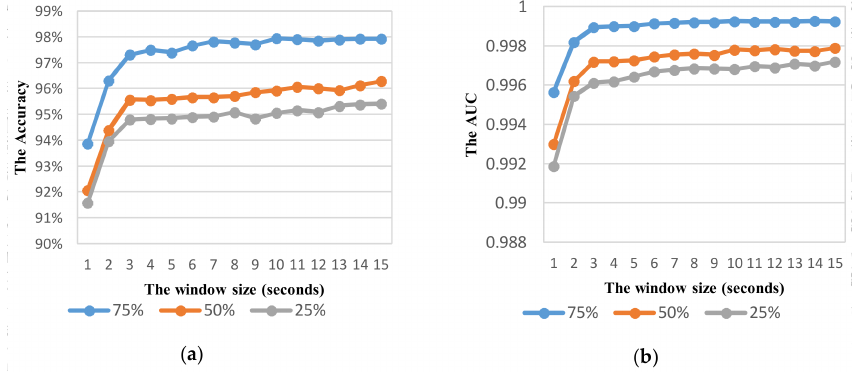
Figure 7. Effect of window size on the vehicle mode detection system performance with different amount of overlapping based on the metric: ( a ) Accuracy; ( b )